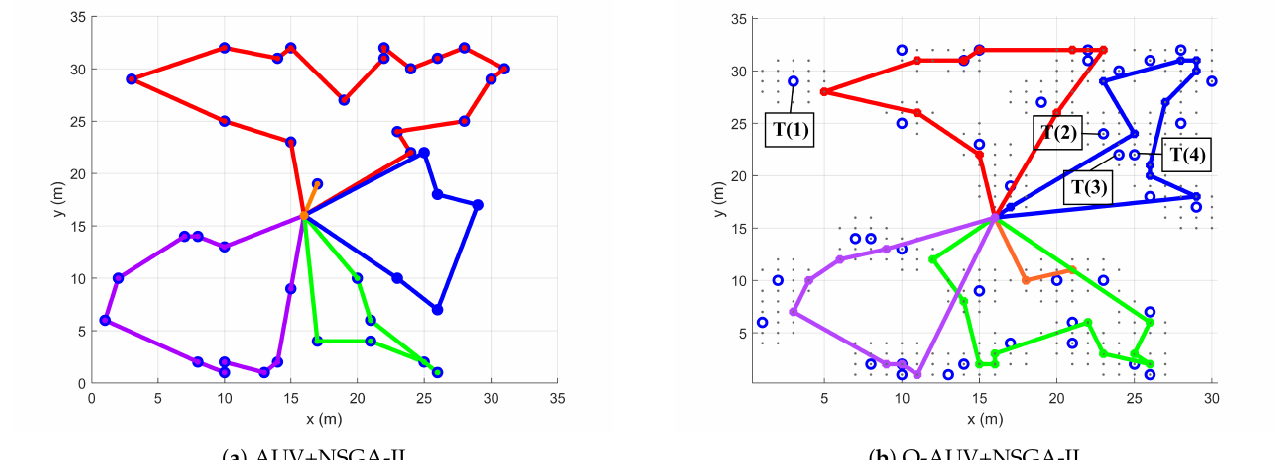
Figure 14. Comparison plots of the trajectories.